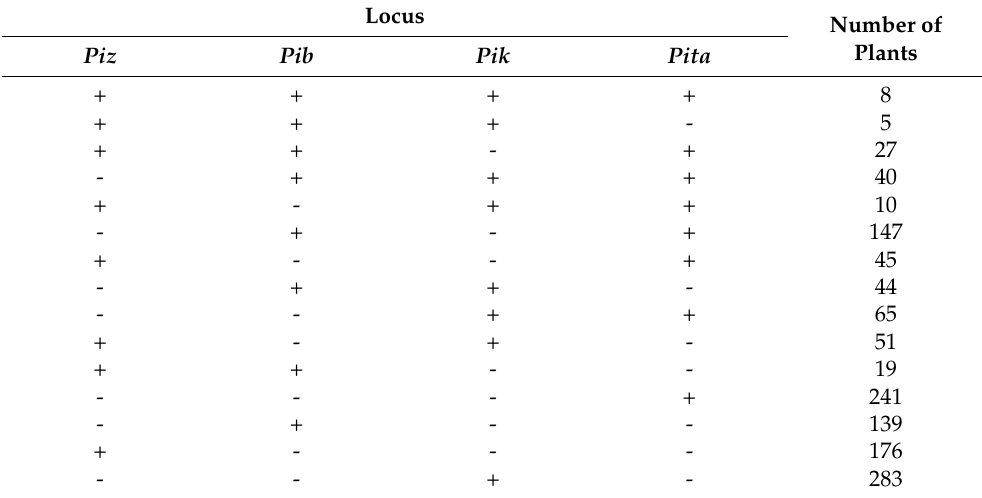
Table 3. Number of plants for each Pi gene combination out of 2364 BC 3 F 2 screened lines.